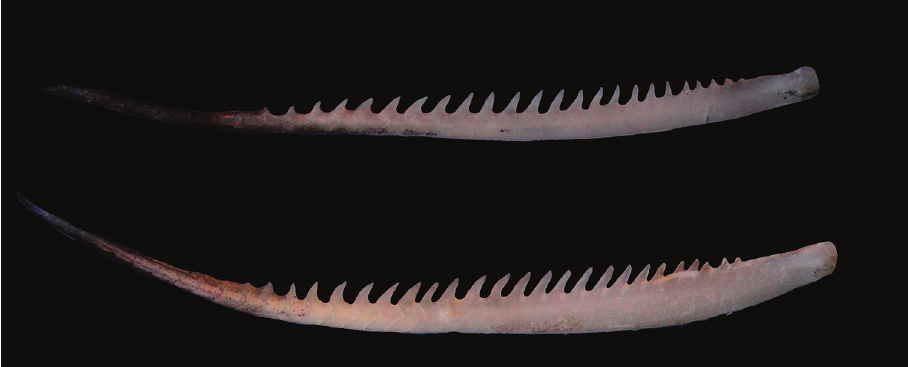
Figure 7. Last simple dorsal-fin rays, Capoeta razii sp. n. (Below, IMNRF-UT-1066-9, SL: 116) and C. capoeta (Above, IMNRF-UT-1067-13, SL: 121 mm). Table 7. Number of total lateral-line scales in Capoeta razii sp. n. and C. capoeta . Species